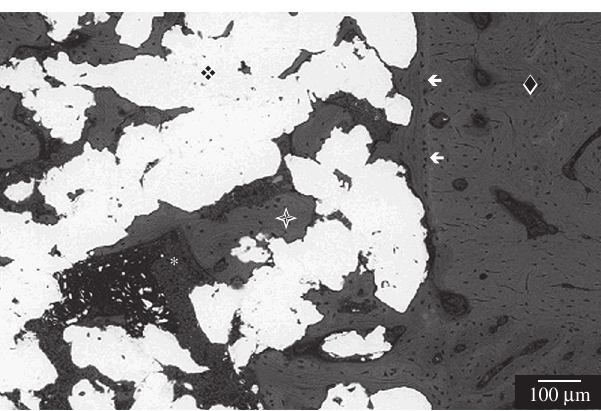
Figure 7. SEM photomicrograph of porous titanium scaffold (  ), 4 weeks after implantation in rabbit tibia (  ): distinct border between new and pre- existing bone (  ), bone ingrowth (  ), and resin (*).